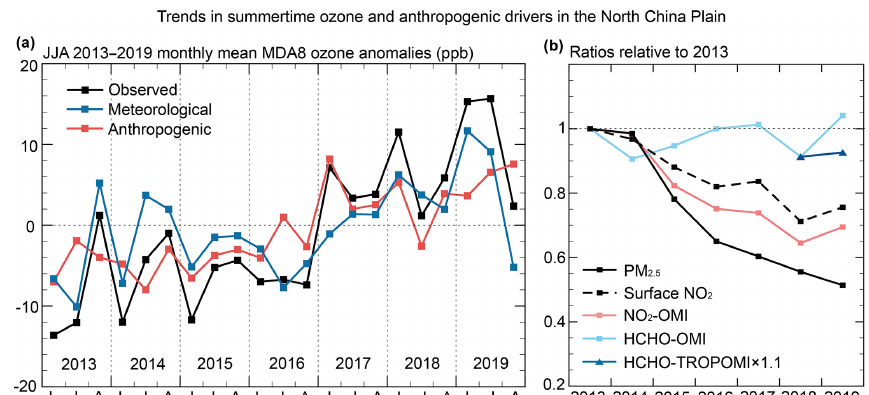
Figure 6. Trends in summertime ozone and related anthropogenic drivers in the North China Plain (NCP). Panel (a) shows time series of monthly mean MDA8 ozone (ppb) anomalies averaged over the MEE sites relative to the 2013–2019 summer (JJA) mean. Values are shown as anomalies for individual JJA months (three points per year). Observed trends are compared to the meteorologically driven trends diagnosed by the MLR model and to the residuals determining the anthropogenically driven trend. Panel (b) shows time series of observed JJA mean quantities averaged over the NCP: PM 2 . 5 (black, solid) and NO 2 (black, dashed) concentrations from the MEE sites, tropospheric NO 2 (pink, solid) and HCHO (light blue, solid) column densities from the OMI satellite instrument, and HCHO column density from the TROPOMI satellite instrument (dark blue, solid). Values are presented as ratios relative to 2013. The TROPOMI HCHO data for 2018 have been scaled to the OMI data for that year with the multiplicative factor indicated in